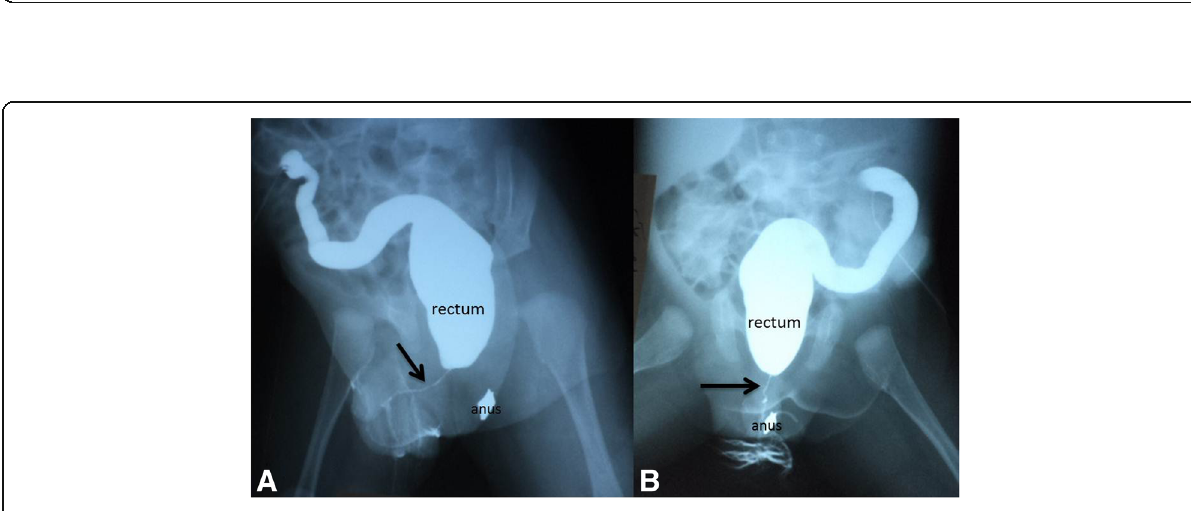
Fig. 15 Recto-perineal fistula in an infant. a , b AP and oblique colostogram images showing the fistulous tract (arrow) between the rectum and the perineum. The mark denoting the anus